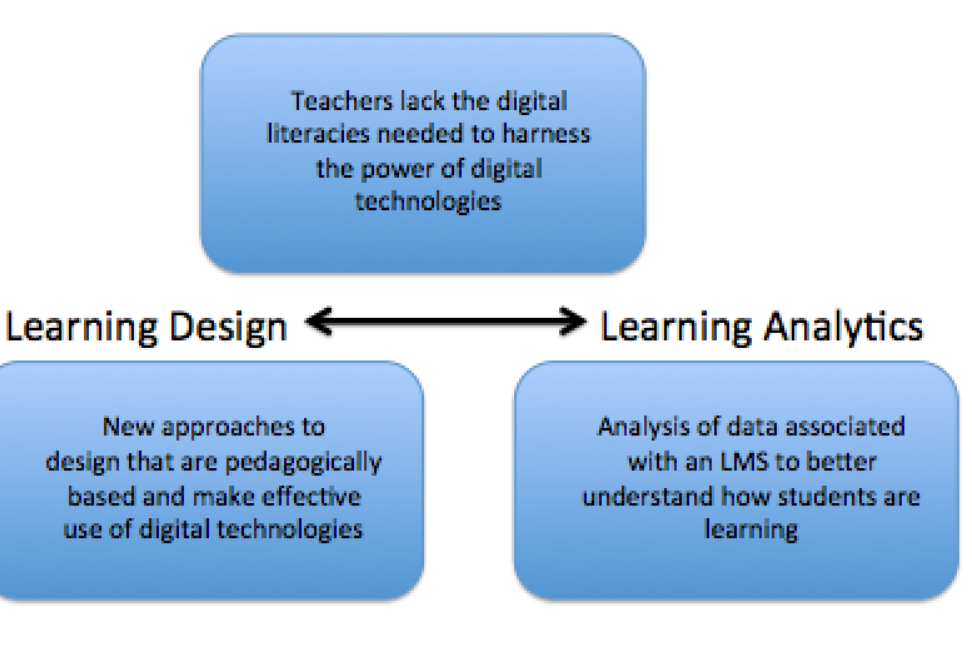
Figure 6: Enabling digital